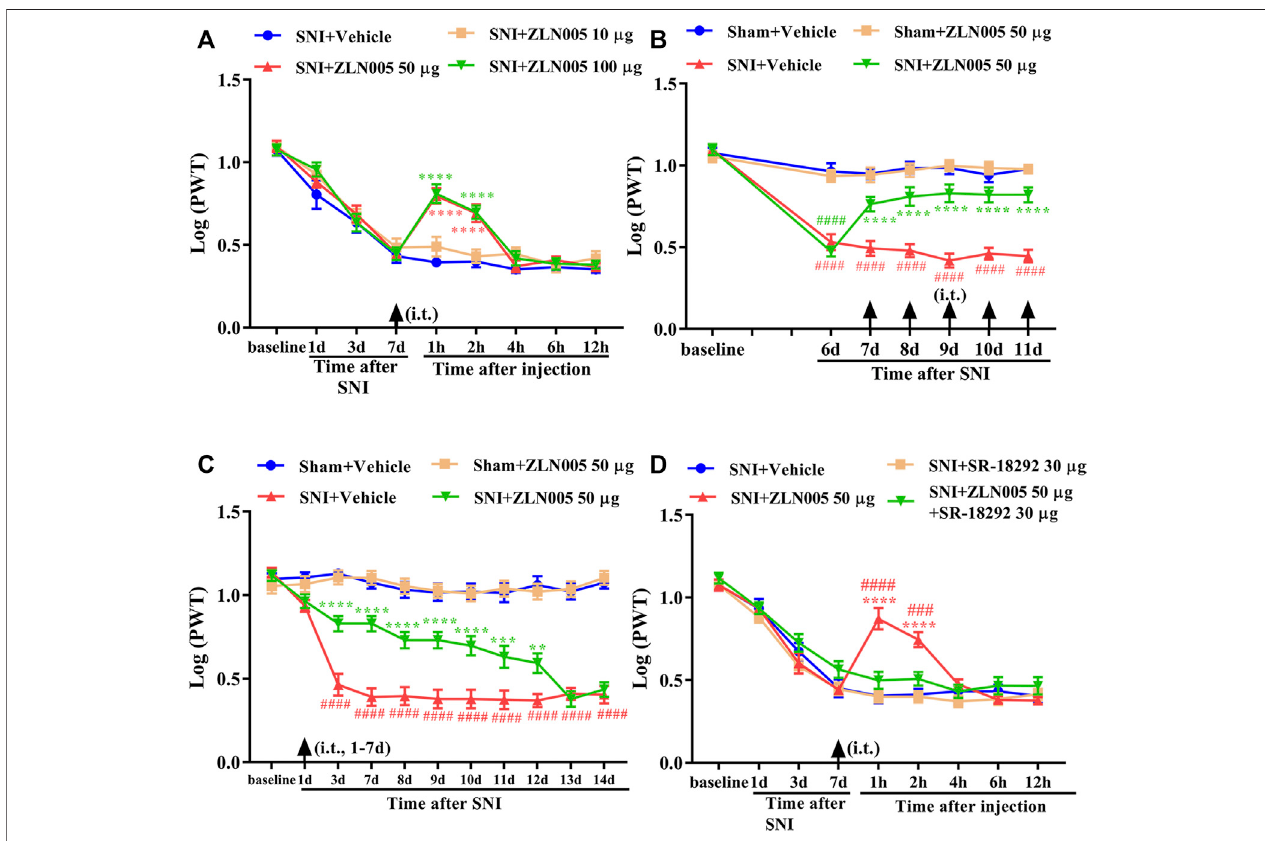
FIGURE 2 | Analgesic effect of PGC-1 α activator on mechanical allodynia in neuropathic pain rats. (A) A single dose of ZLN005 (50 and 100 μ g) signi fi cantly increased the PWT in SNI rats, peaking at 1 h, and lasted for at least 2 h (**** p < 0.0001 compared with SNI + Vehicle group, n = 10 in each group). (B) Repetitive injections of ZLN005 (50 μ g, i. t.) considerably reversed established mechanical allodynia in SNI rats (**** p < 0.0001compared with SNI + Vehicle group, #### p < 0.0001 compared with Sham + Vehicle group, n = 10 in each group). (C) The PWT was signi fi cantly increased from day 3 to day 12 in ZLN005-treated SNI rats compared withvehicle-treatedSNIrats(** p < 0.01,*** p < 0.001,**** p < 0.0001comparedwithSNI+Vehiclegroup, #### p < 0.0001comparedwithSham+Vehiclegroup,n=10in each group). (D) The analgesic effects of ZLN005 were reversed by PGC-1 α inhibitor SR-18292 (**** p < 0.0001 compared with SNI + Vehicle group, ### p < 0.001, #### p < 0.0001 compared with SNI + ZLN005 50 μ g + SR-1892 30- μ g group, n = 10 in each group).